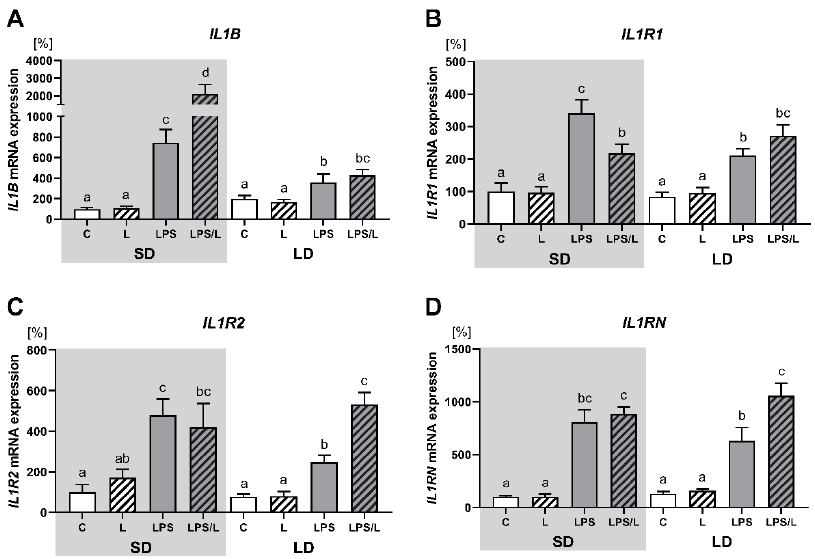
Figure 3. Mean (±SEM) relative IL1B ( A ), IL1R1 ( B ), IL1R2 ( C ) and IL1RN ( D ) mRNA expression in the ovine choroid plexus of saline (C, control—white bars), saline–leptin (L, white hatched bars), LPS (grey bars) and LPS–leptin (LPS / L, grey hatched bars) treated ewes, during the short-day (SD, dark background) and the long-day (LD, light background) photoperiod. Di ff erent lowercase letters indicate significant di ff erences between all groups at p < 0.05 (two-way ANOVA—Tukey’s post